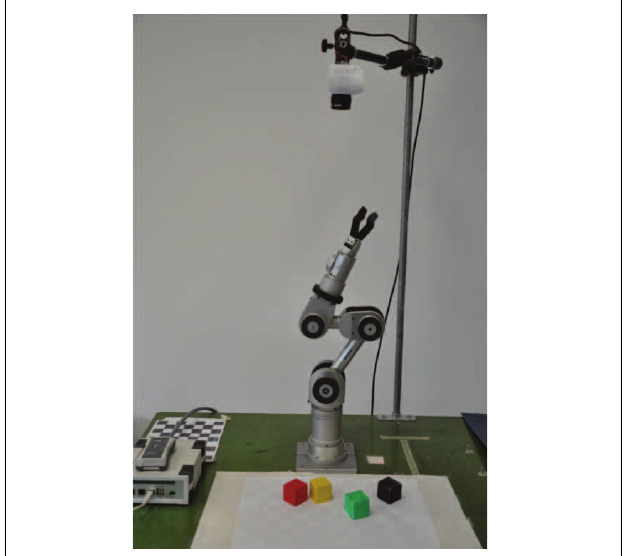
FIGURE 1 | The Katana robot arm in its blocks-world